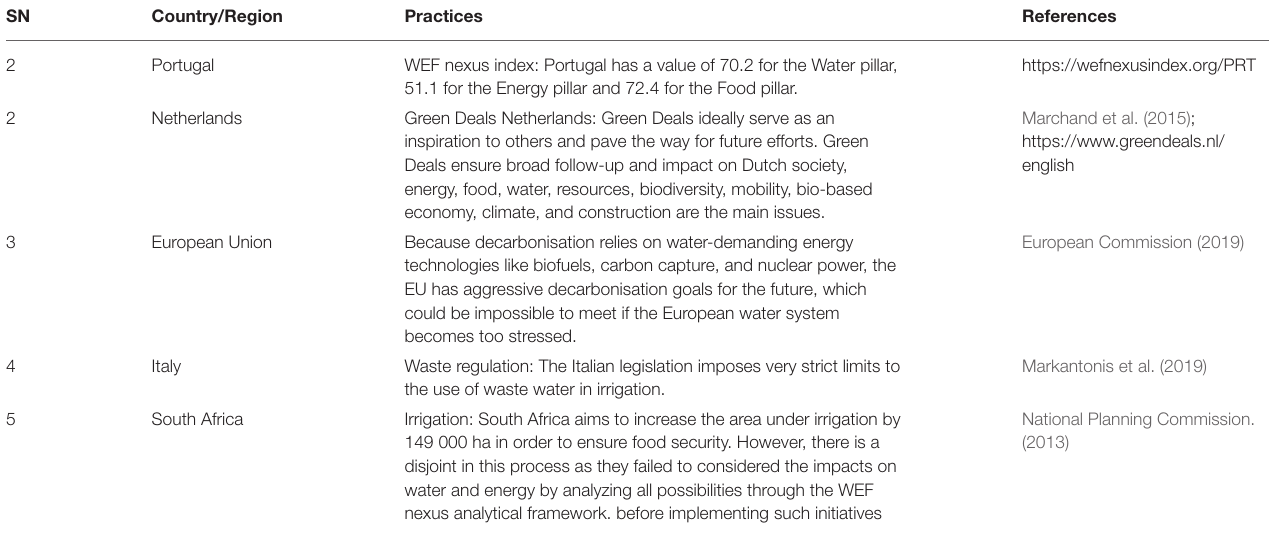
TABLE 4 | WEF nexus implementation.